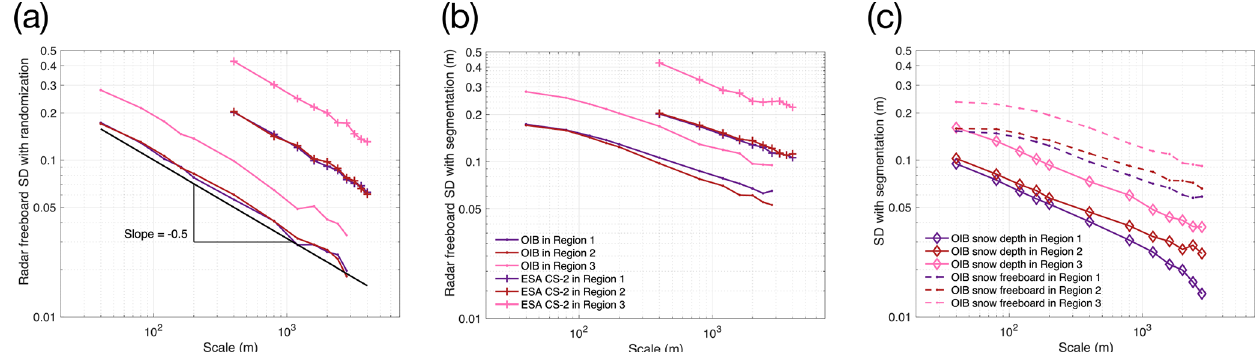
Figure 3. Statistical scaling of sea ice measurements by OIB and CS-2 for sample regions in Fig. 2. Scalings of F r under randomized sampling (or local averaging) by OIB (dots) and CS-2 ( + ) are shown in (a) (or b ). Scalings of OIB-measured h s (diamond) and F s (dashed) are shown in (c)